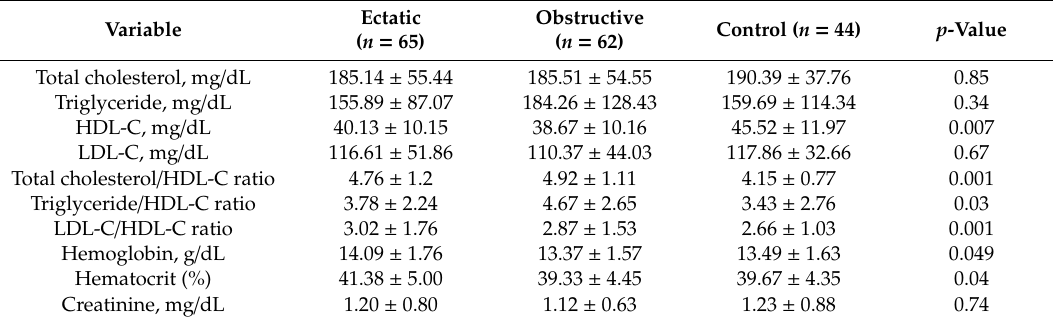
Table 2. Biochemical and hematological measurements of the study